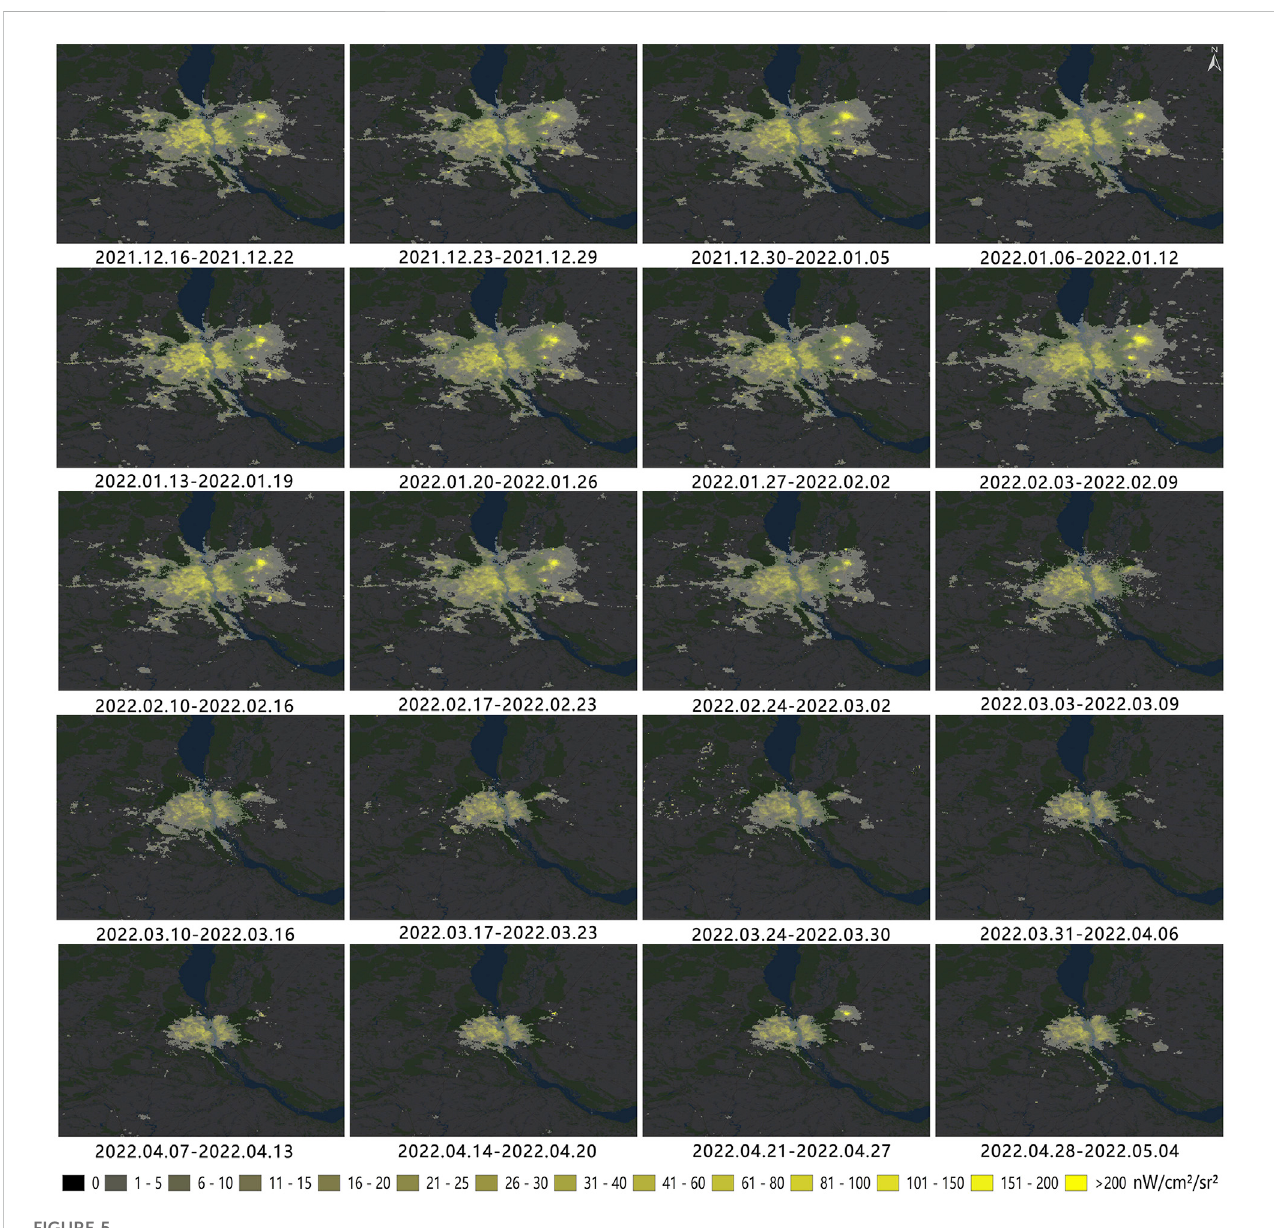
FIGURE 5 Weekly Kyiv city nighttime light spatial change from 16 December 2021 to 2 May